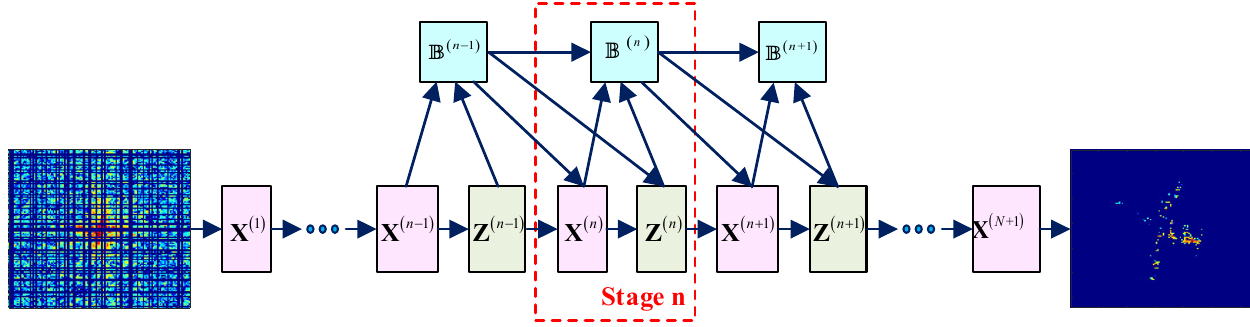
Figure 1. Structure of the 2D ‐ ADN.